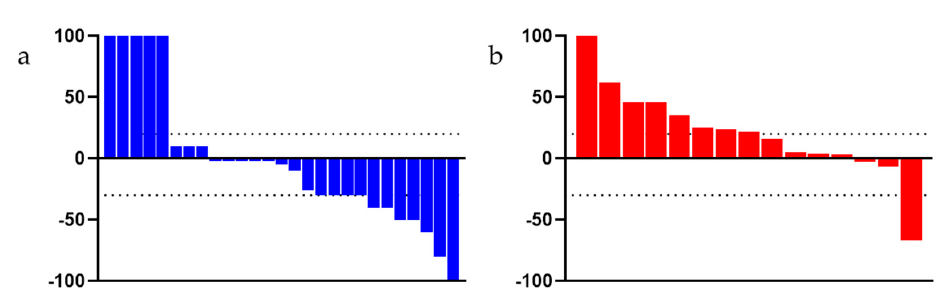
Figure 5. Waterfall Plot evaluating the objective responses of patients, ( a ) treated with FFN and ( b ) treated with GemNab. The dotted bar indicates +20% and − 30%, range for stable disease, as per RECIST criteria.